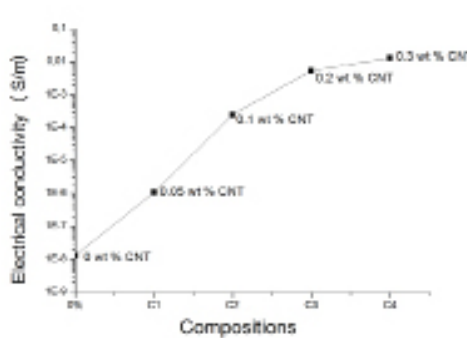
Figure 2. Electrical conductivity of epoxy and epoxy/CNT nanocomposites at 1 Hz.